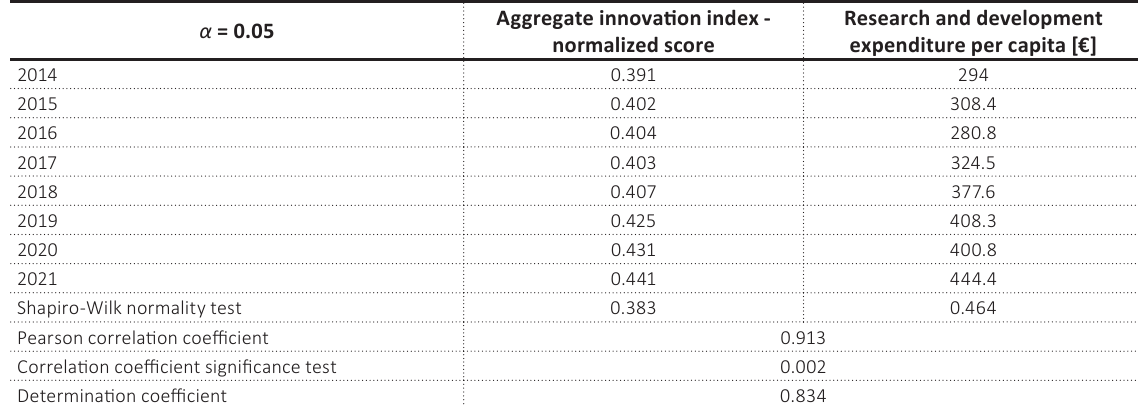
Table 2. Test statistics – Czechia